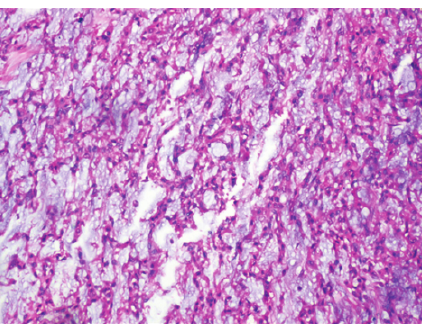
Figure 2: Spindle cells enmeshed in myxoid stroma (H & E × 100).